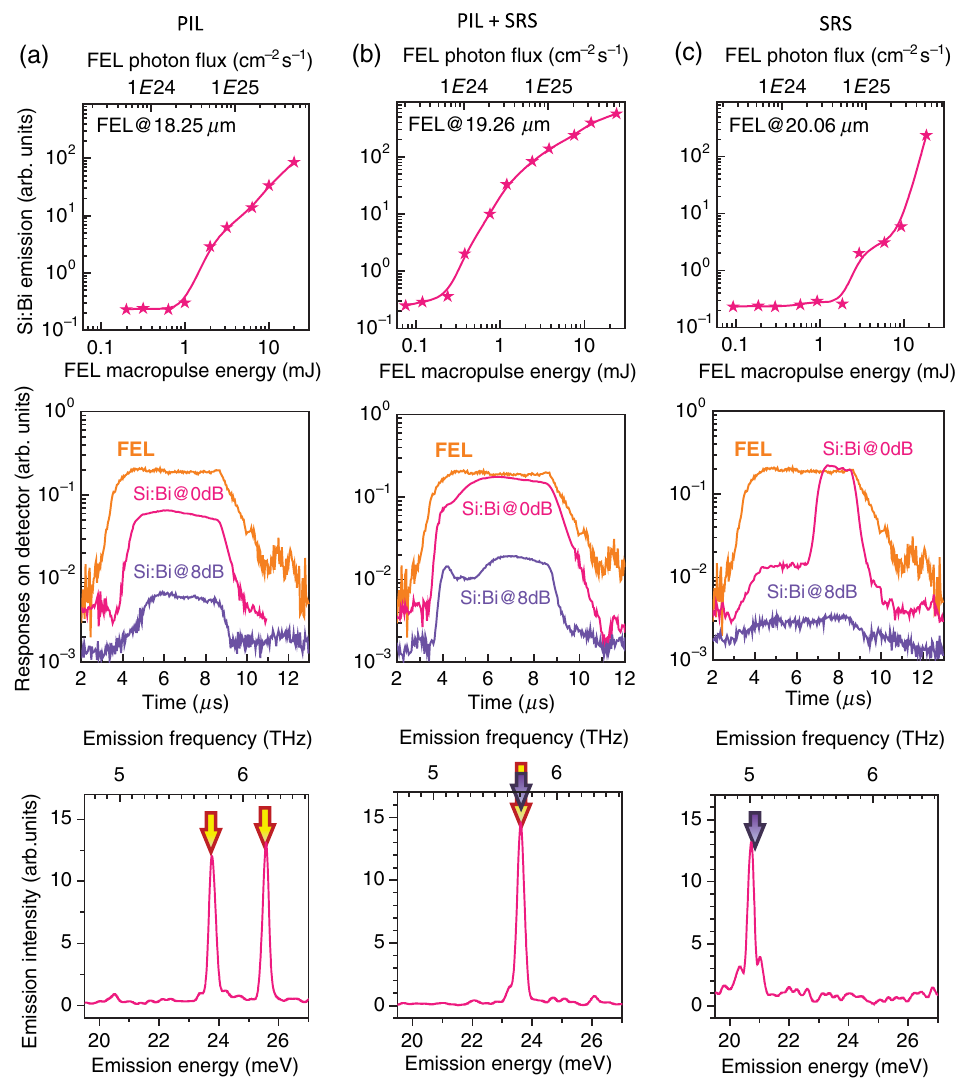
FIG. 4. Lasing thresholds, dynamics, and emission spectra for different laser mechanisms in Si ∶ Bi. (a) Typical four-level population inversion scheme (PIL): The pump photon energy corresponds to the excitation of bound electrons into a higher excited state. The laser → 1 s ð E Þ and 2 p → 1 s ð T 18 . 25 μ m transitions are 2 p 2 Þ at 5.75 and 6.16 THz, correspondingly. The FEL pump wavelength is (cid:2) (cid:2) (16.43 THz or 67.95 meV) and the photon flux is 4 × 10 25 cm − 2 s − 1 . (b) Simultaneous operation of Raman and population inversion lasing (PIL and SRS): The pump photon energy corresponds to excitation in the 2 p Bi state. The previously distinct laser lines merge (cid:2) → 1 s ð E Þ Bi transition. The FEL pump wavelength is 19 . 26 μ m into one emission line which corresponds to the energy of the 2 p (cid:2) (15.57 THz or 64.4 meV) and the photon flux is 4 × 10 25 cm − 2 s − 1 . (c) Raman lasing scheme (SRS): The pump photon energy corresponds to excitation into a virtual state. The Stokes emission line is from the virtual state into the 1 s ð E Þ state (5.04 THz or 20.84 meV). The FEL pump wavelength is 20 . 06 μ m (14.95 THz or 61.81 meV) and the photon flux is 5 × 10 25 cm − 2 s − 1